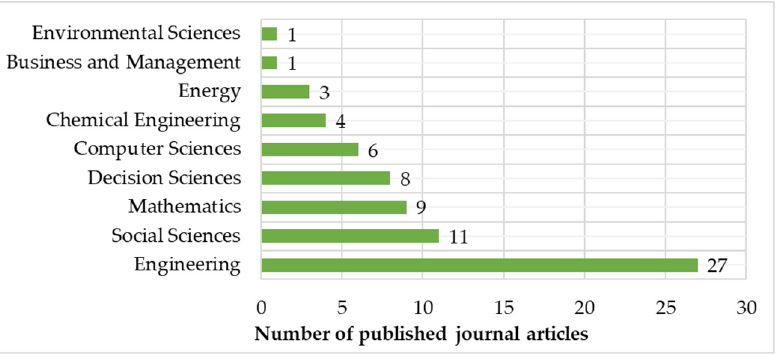
Figure 3. Classification of articles by subject areas based on search in Science Direct.